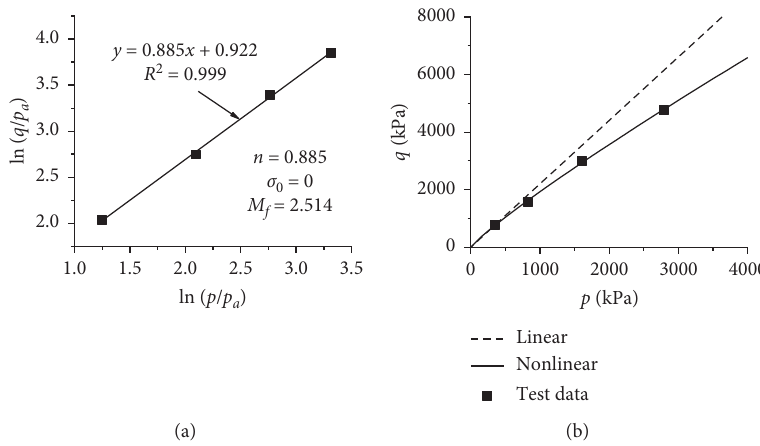
Figure 6: Verifications of the two criteria. (a) Parameter determination. (b) Test data in the p − q diagram.